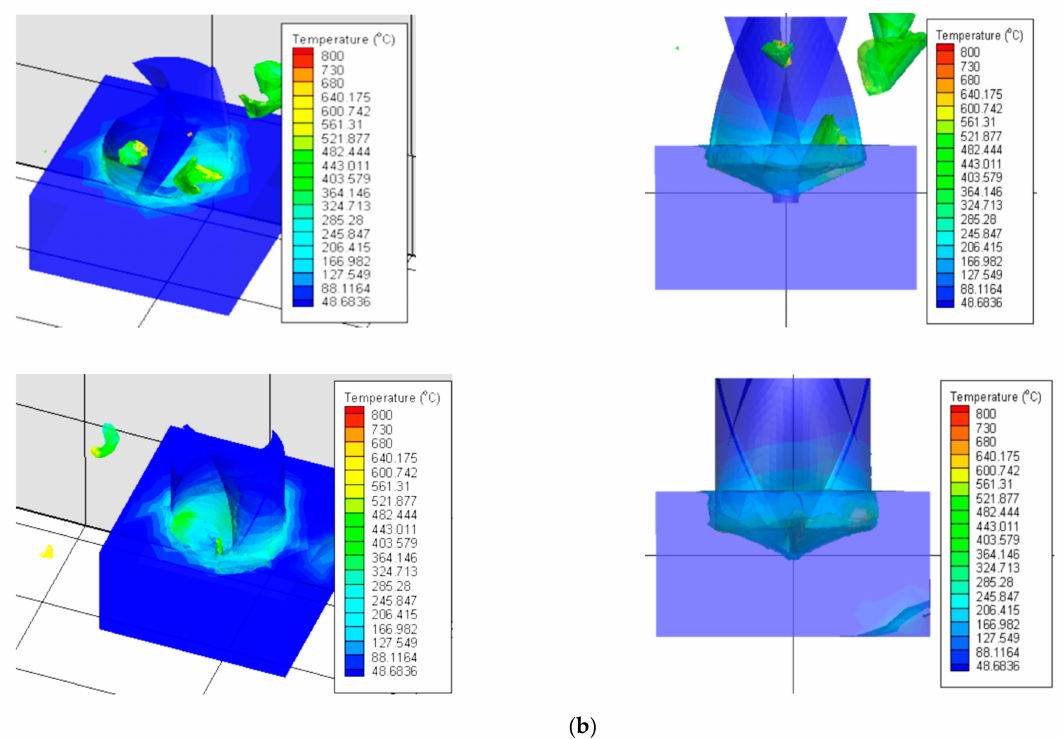
Figure 7. ( a ) Sample FE simulation showing chip formation for feed rate 0.375 mm/rev and 1000 spindle rpm ( b ) FE simulation (feed rate 0.75 mm/rev and 3000 spindle rpm) showing phases of starting, only cutting lips engagement with pilot hole and engagement of both cutting lip and chisel edge.